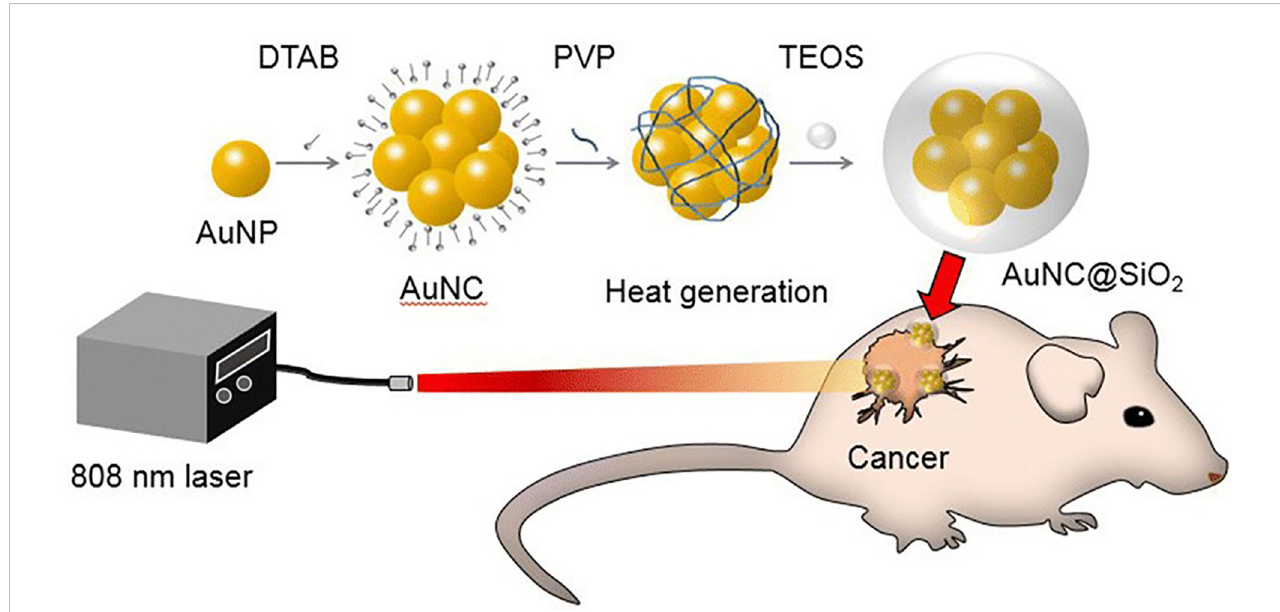
FIGURE 7 Graphical illustration showing the photothermal effect of gold nanoparticle clusters (AuNCs)@SiO 2 in a prostate cancer model under near-infrared (NIR) laser irradiation